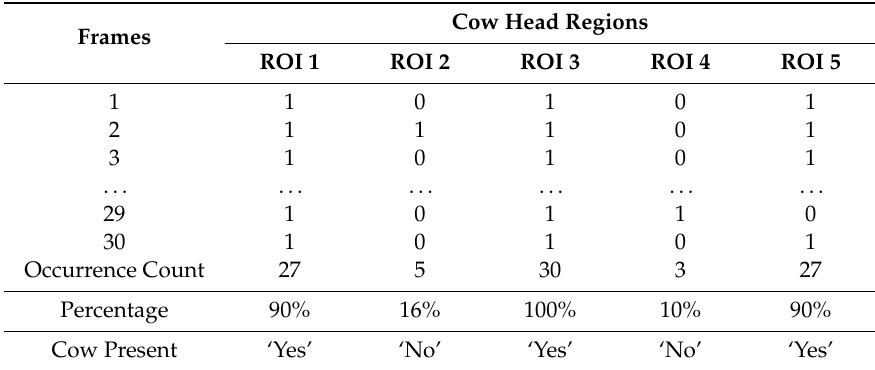
Table 3. Illustration of the cow head decision table.